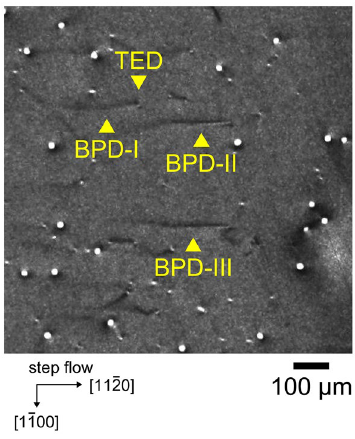
Figure 2. X-ray topography image of specimen without proton irradiation before UV illumination. BPD-I is converted to a TED, and BPD/TED conversion is not observed for BPD-II and